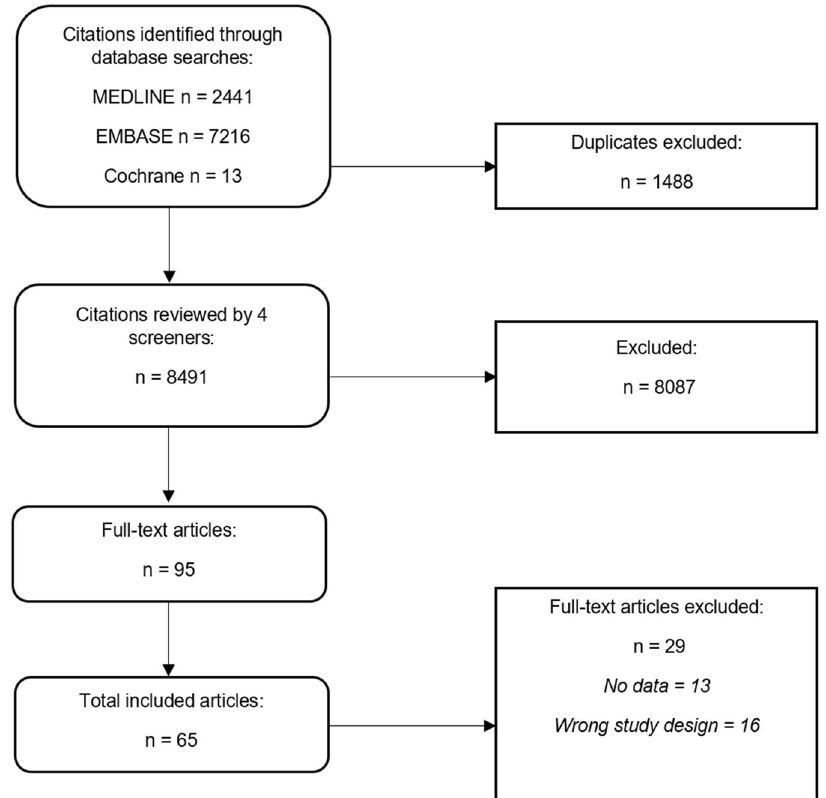
Fig. 1 Study selection fl ow diagram. This fi gure illustrates the process by which articles were selected for inclusion in the